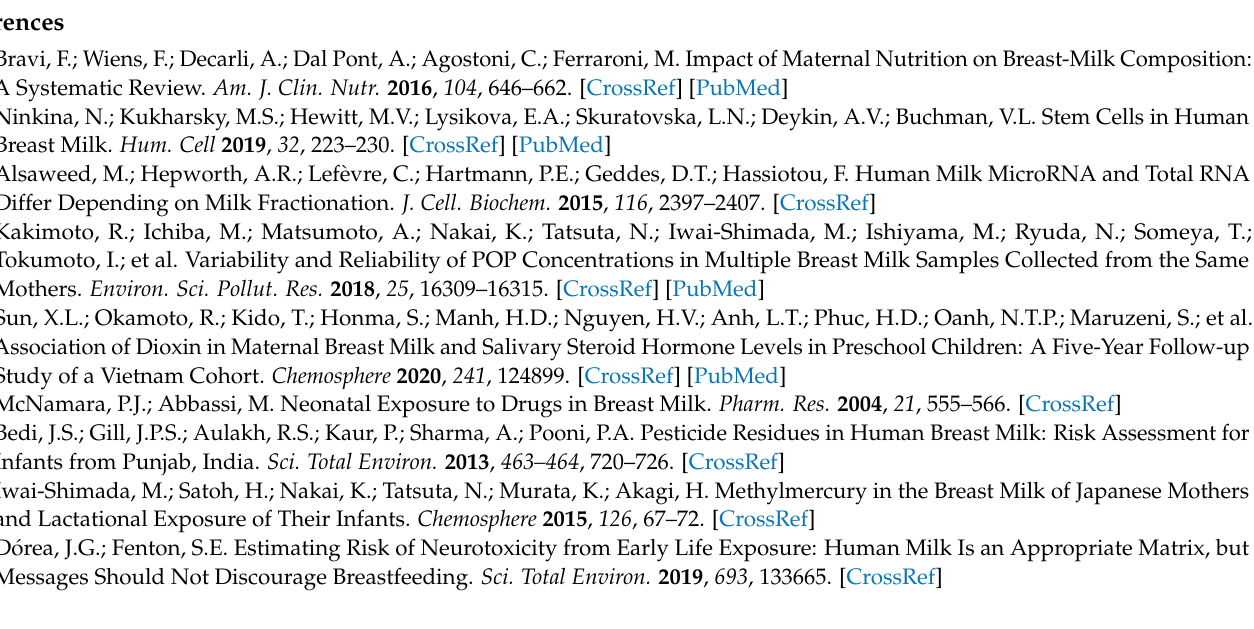
MS analysis of breast milk samples, Table S1: Microwave conditions, Table S2. ICP-MS settings, Table S3. Setting parameters for the ICP-MS method, Table S4. Intra-day variation of elements between fore- and hindmilk, Table S5. Intra-day variation of fat and protein contents between fore- and